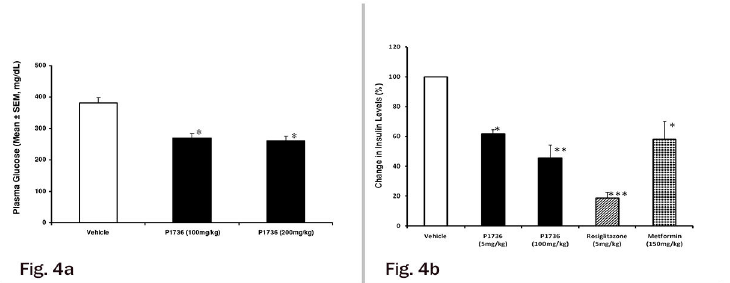
Figure 4. P1736 lowers plasma glucose and insulin levels in insulin resistant and obese ob/ob mice. a , Plasma glucose levels of male ob/ob mice that received oral doses of either vehicle (empty bar) or P1736 (100 mg/kg, 200 mg/kg, solid bars) measured after 10 days. b , Change in plasma insulin levels of ob/ob mice which received vehicle(empty bar) or P1736 (5 mg/kg, 100 mg/kg, solid bars) or rosiglitazone (5 mg/kg, bar with stripes) or metformin (150 mg/kg, dotted bars) for 10 days. Data are expressed in Mean ± SEM for 8 -12 animals per treatment group. Differences between vehicle and treatment groups were statistically evaluated by t-test *p<0.05, **p<0.01, ***p<0.001 vs. vehicle.